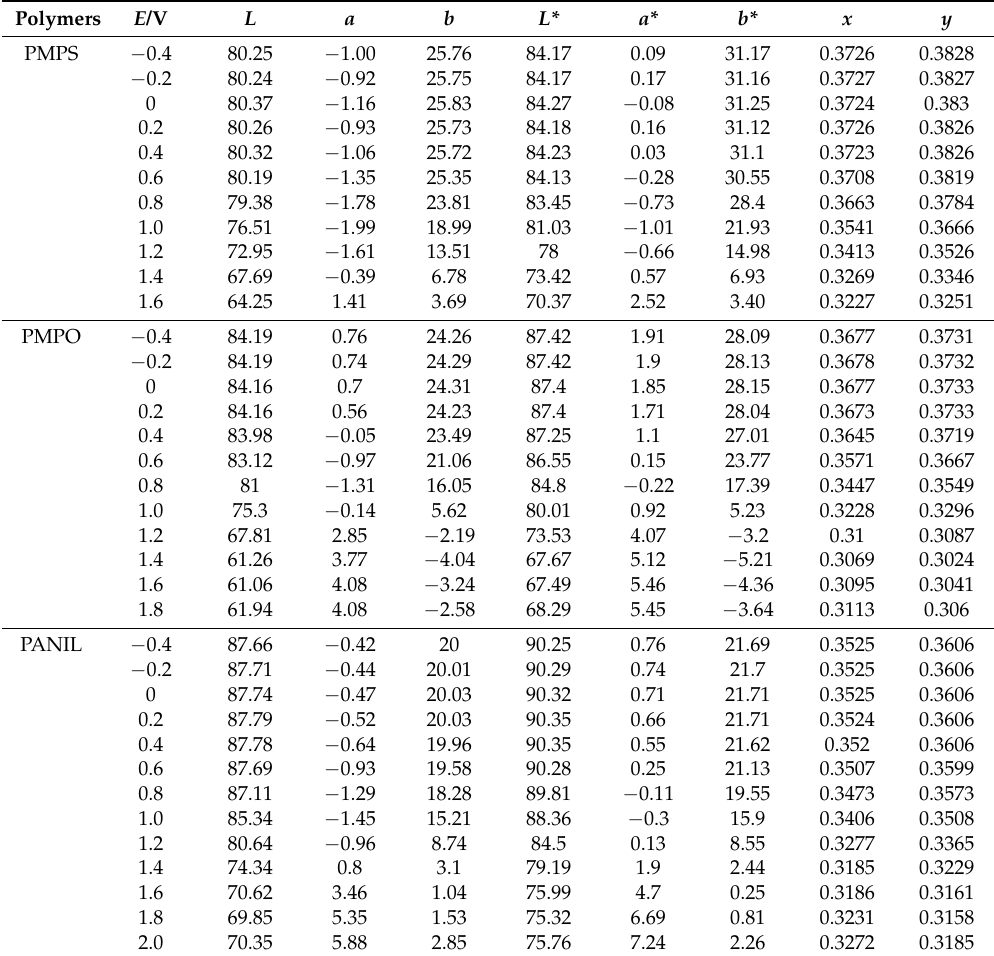
Table 2. The colorimetric values ( L , a , b , L* , a* , b* ) and CIE chromaticity values ( x , y ) of PMPS, PMPO, and PANIL films at different applied potentials in [EPI + ][TFSI − ].